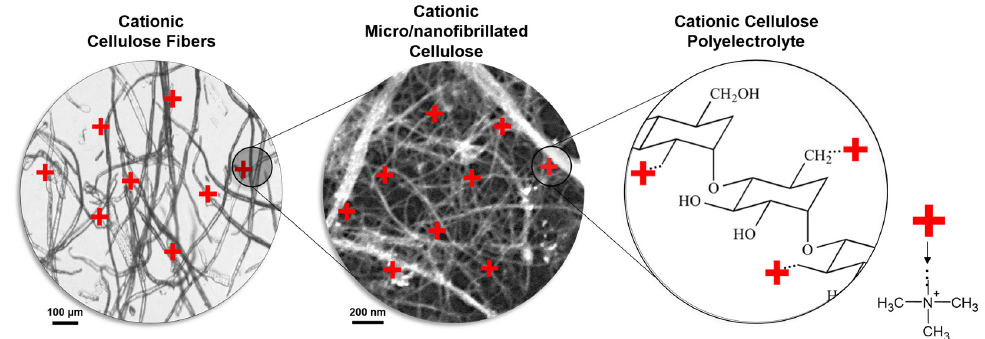
Figure 1. Schematic representation of cationic celluloses with distinct morphologies.